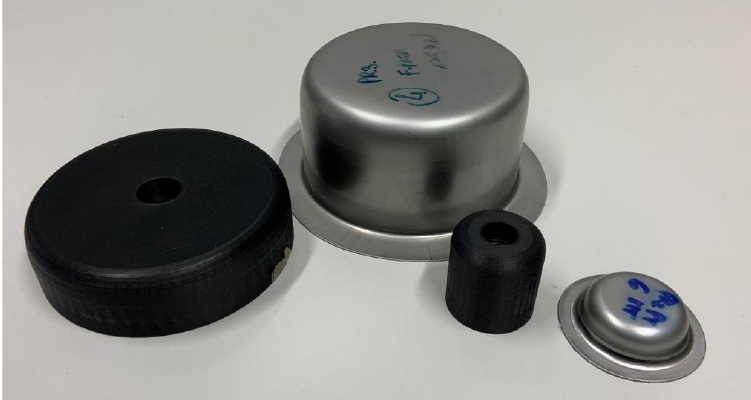
Figure 3. Setup of elements modelled for deep drawing simulations: (a) press; (b) punch; (c) punch